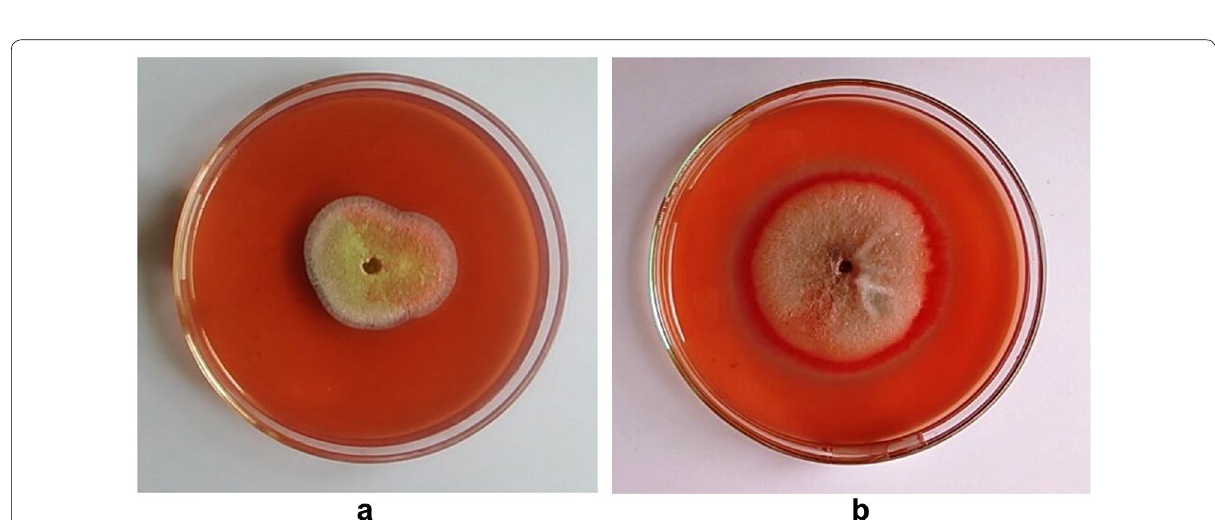
Fig. 2 Detection of xylanase activity from the isolated fungal strain on agar plates. Plates showing the zone of hydrolysis by Aspergillus fumigatus JCM 10253 with Congo red staining on the 7th day. a Plate without xylan; b plate with xylan as a